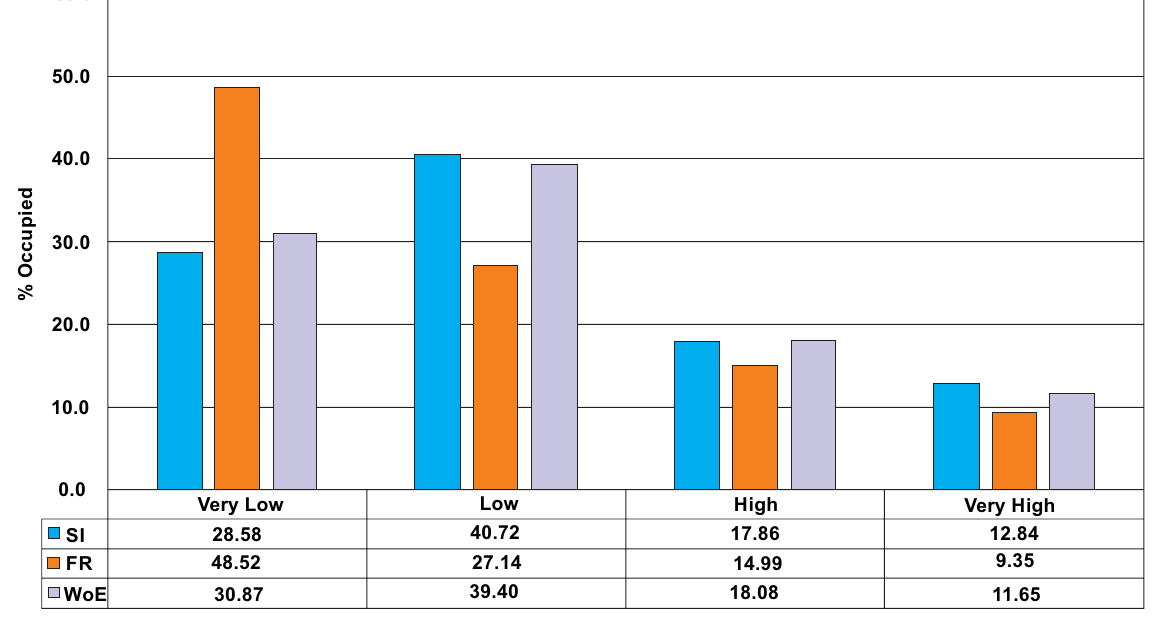
Figure 7. Percentile distribution of predictive class within each